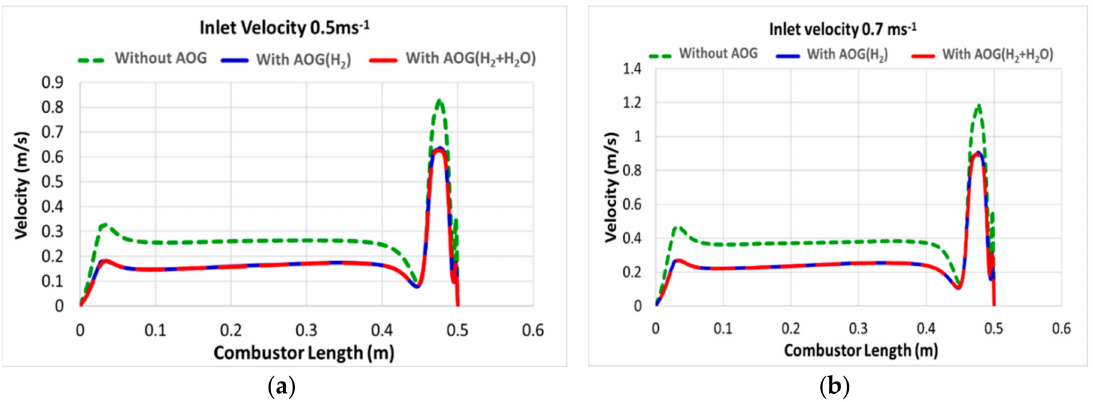
Figure 11. Velocity distribution along the combustor length at ( a ) 0.5 m / s and ( b ) 0.7 m / s inlet velocities for all the three cases is investigated.